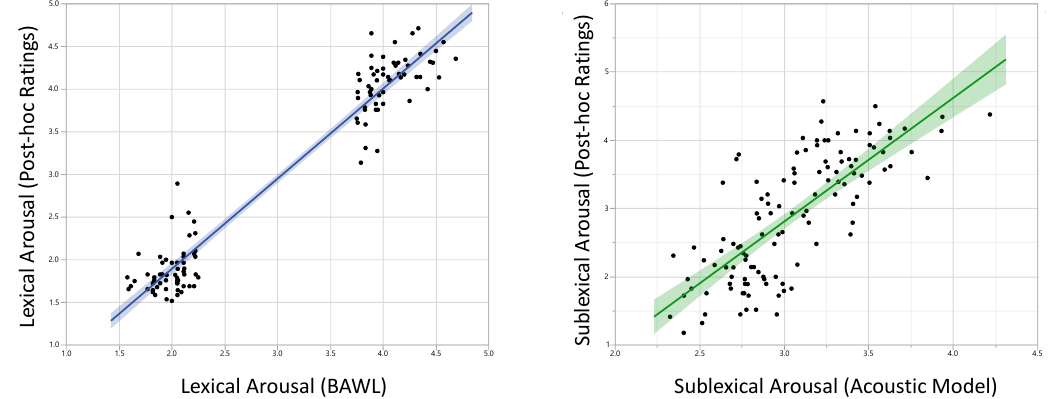
Figure 1. Results of post-scan ratings were highly correlated with affective measures used for the fMRI-experiment. Left: lexical arousal ( r = 0.97), Right: sublexical arousal ( r = 0.76).